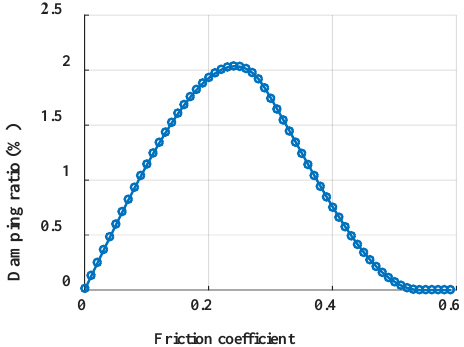
Figure 21. Damping characteristics at different friction coefficients for labyrinth seal.